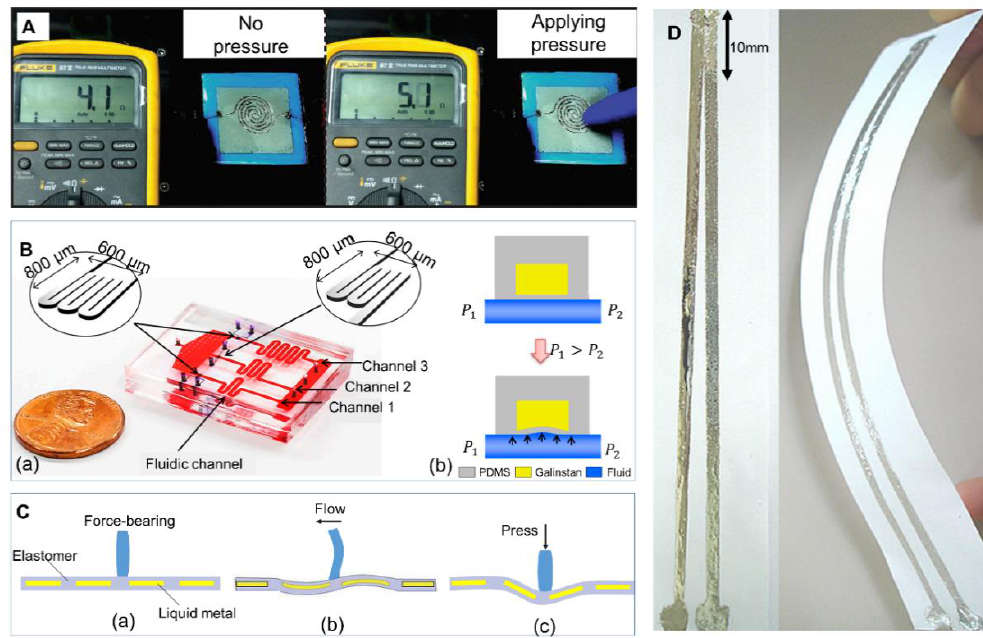
Figure 10. Photos of force sensors, temperature sensors and blood glucose sensors. ( A ) The resistance of a printed pressure sensor according to external pressure, reproduced with permission from [110]. ( B ) A micro-channel pressure sensor: ( a ) Structure of the sensor; ( b ) Working principle of measuring viscosity of various fluids; Reproduced with permission from [95]. ( C ) Schematic of artificial hair cell sensor: ( a ) No external force; ( b ) Deformation under a shear force; ( c ) Deformation under a normal force. ( D ) Thermocouple based on liquid metal printed on paper, reproduced with permission from [109].